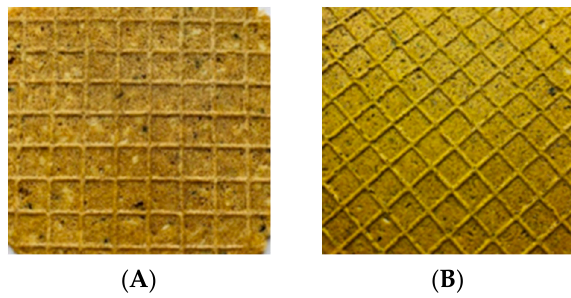
Figure 1. Control sample ( A ) vs. spent grain sample ( B ).